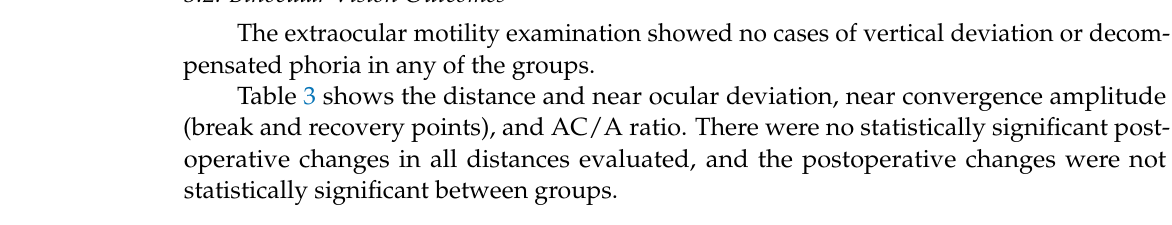
Table 3. Distance and near ocular deviation, near convergence amplitude, and AC/A ratio for high- and low-to-moderate-power group at one week and one month after